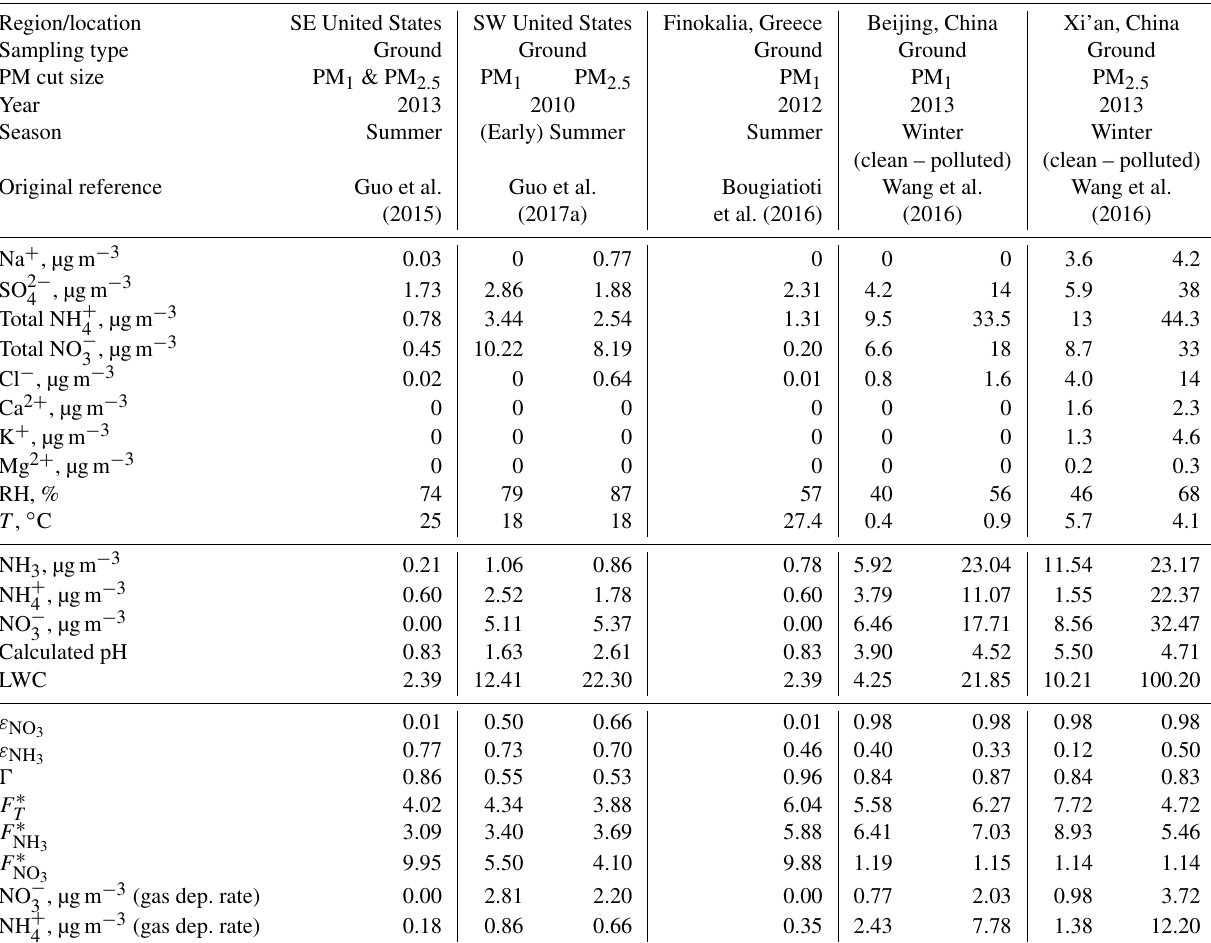
Table 1. Aerosol composition and meteorological conditions for flux deposition calculations and aerosol composition changes from modi- fications to the deposition velocity. The reported aerosol precursor concentrations, LWC, RH, and T are obtained from Table S1 of Guo et al. (2017b), but original references from which the data were obtained are also shown in row 6. Data for Finokalia, Greece, were obtained from Bougiatioti et al. (2016), assuming that the total NO − is equal to the aerosol nitrate, and total NH + is equal to the aerosol ammonium 3 4 then presented in rows 17–21. These data and the equations presented in the text are utilized to compute the quantities remaining in rows